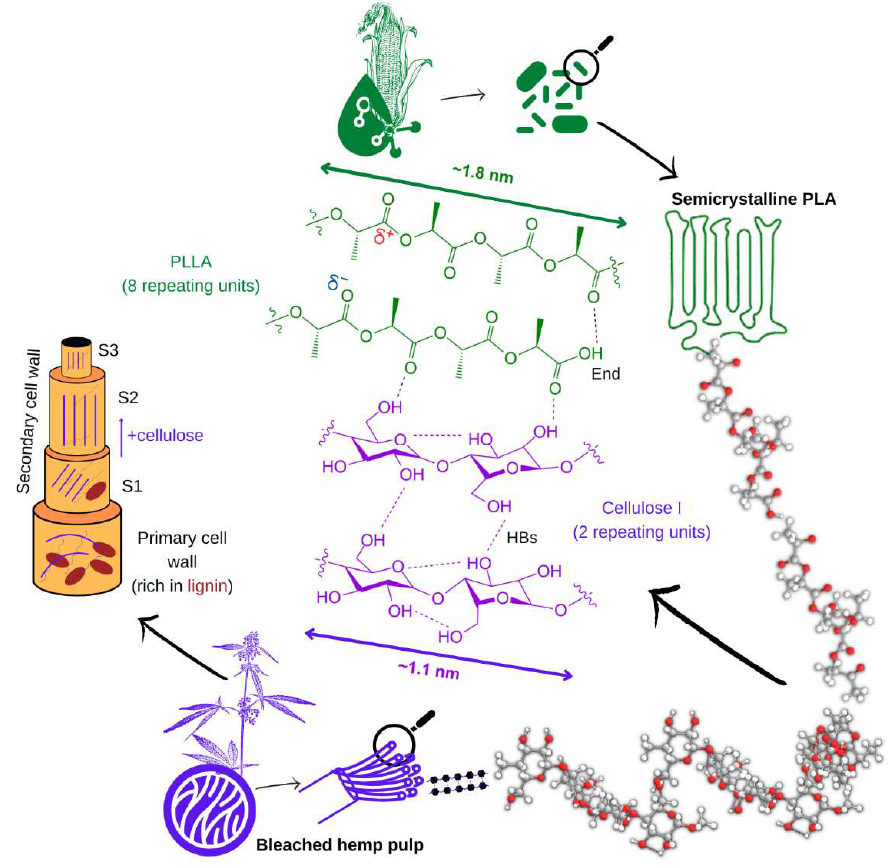
Figure 7. Structures of the repeating units of cellulose (crystalline polymorph I) and PLA (as intrin- sically isotactic PLLA), highlighting their interactions and schematizing supramolecular